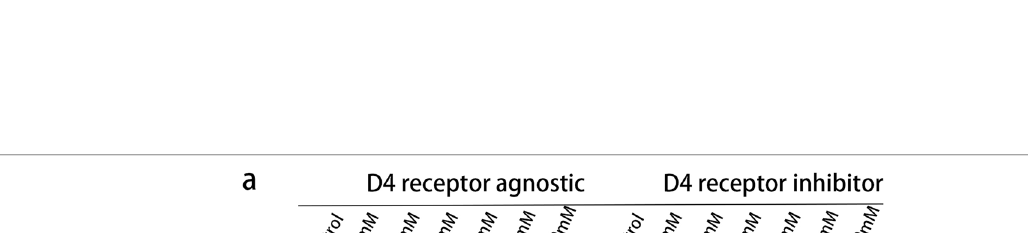
NaCl at 1 g/L), high salinized freshwater + NaCl at 5 g/L). a AHI (RV/ +